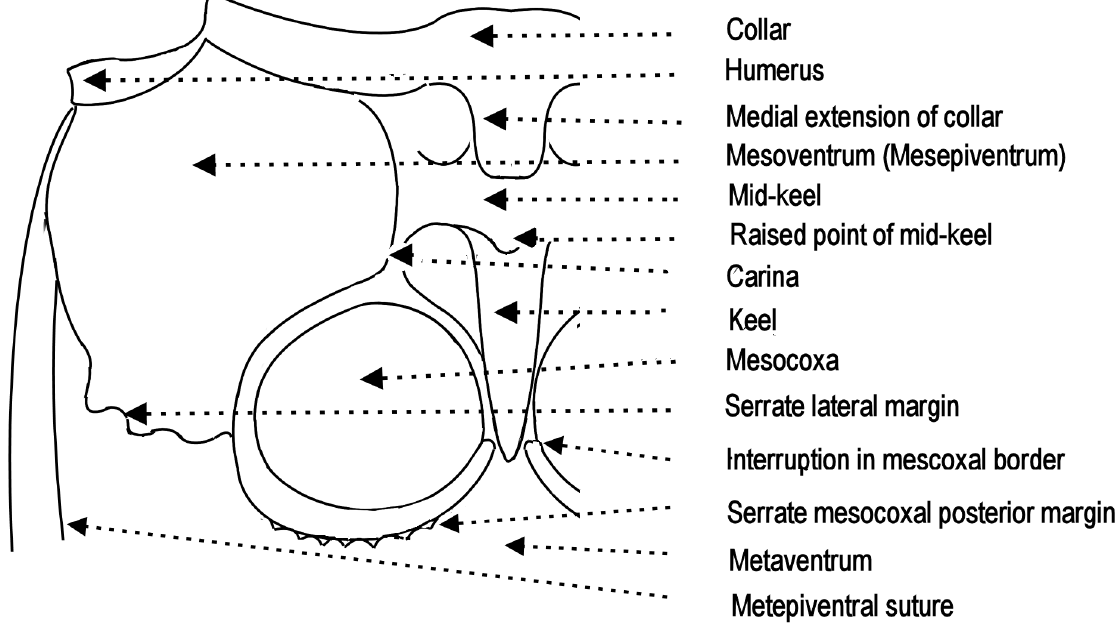
Fig. 1. Diagram of the ventral side of the pterothorax to explain terms used in the